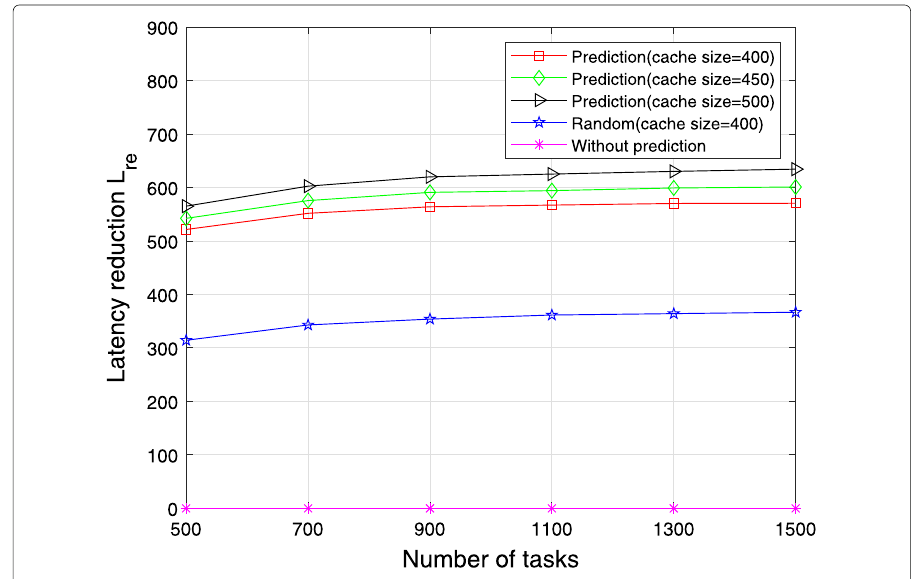
Fig. 10 Latency reduction versus the number of